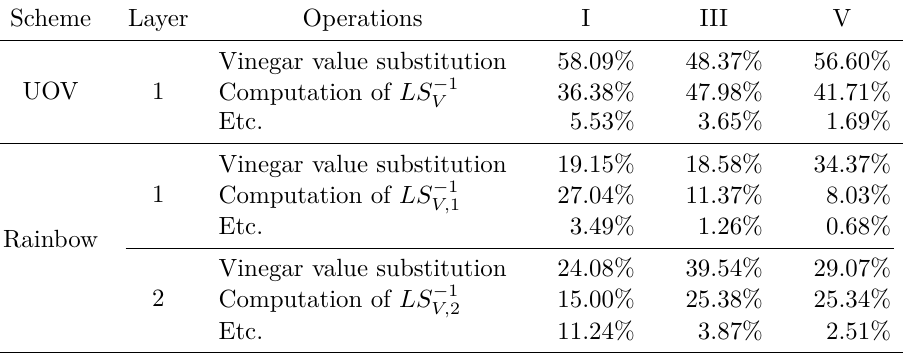
Table 3: Profiling UOV/Rainbow implementations at three security categories.